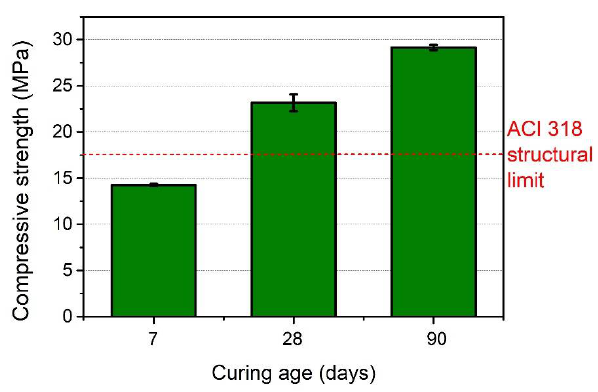
Figure 11. Evolution of compressive strength of the hybrid concrete. Table 6. Physical properties of the hybrid concrete (28 days).